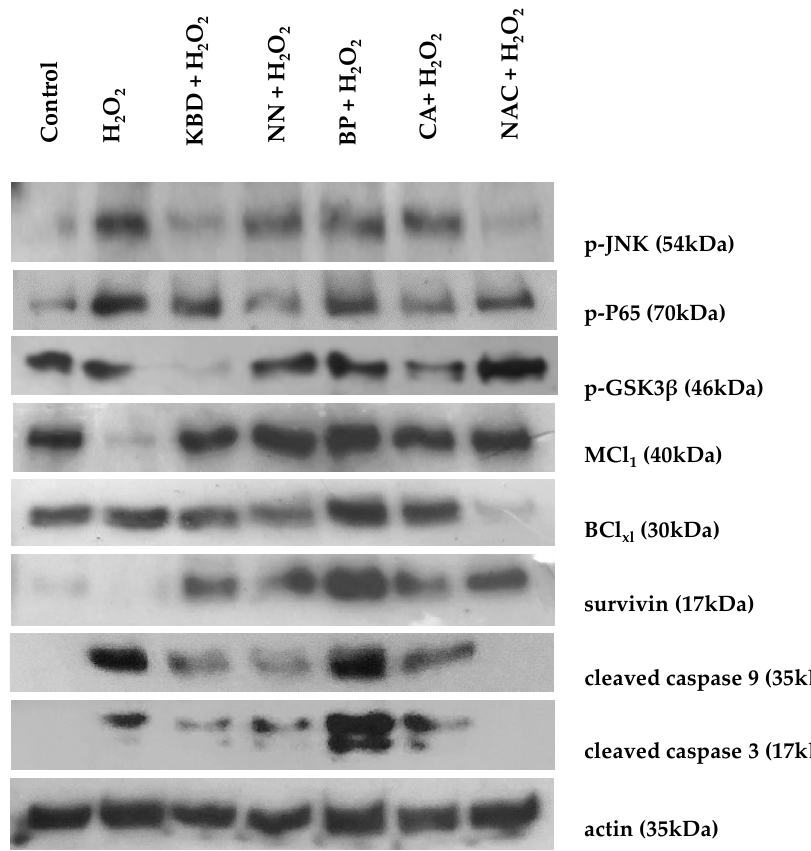
Figure 5. Effect of the KBD (100 μg/m L) and its components ( Nelumbo nucifera (NN), Piper nigrum (BP), and Centella asiatica (CA), 35 μg/m L) extracts on protein expression by Western blot analysis. The SH-SY5Y cells were treated with the KBD extract for 30 min by using N -acetyl cysteine (NAC) as a positive control, and then treated with 250 µ M H 2 O 2 for 10 min. The cell lysate was prepared and signaling proteins were detected using antibodies against the following: (i) p-JNK, (ii) p-P65, (iii) p-GSK3 β , (iv) MCL 1 , (v) BCl xl , (vi) survivin, (vii) cleaved caspase-9, (viii) cleaved caspase-3, and (ix) actin.